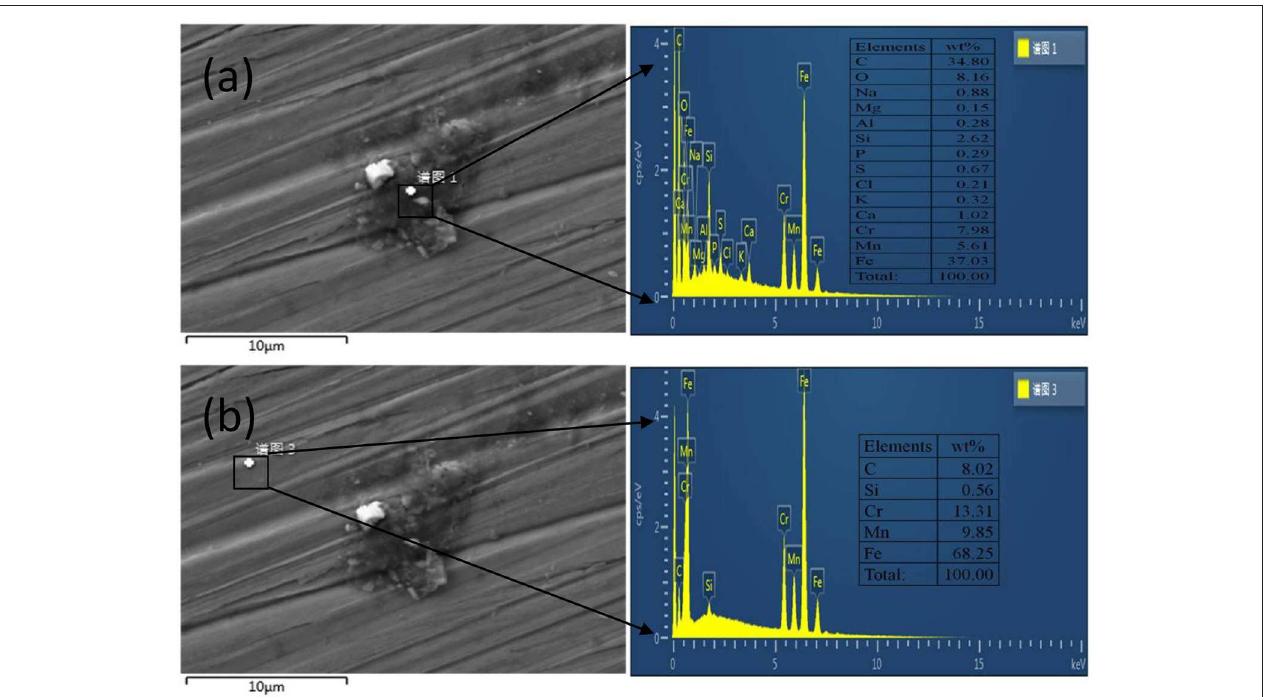
FIGURE 3 | Scanning electron microscopy (SEM) morphologies and energy-dispersive X-ray spectroscopy (EDS) analyses of corrosion products on the surface of A2 coupon exposed to sulfate-reducing bacteria (SRB) for 25 days. (a) Position of EDS analysis: biofilm/corrosion products, (b) Position of EDS analysis: matrix.